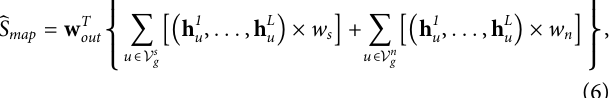
Frontiers in Molecular Biosciences |